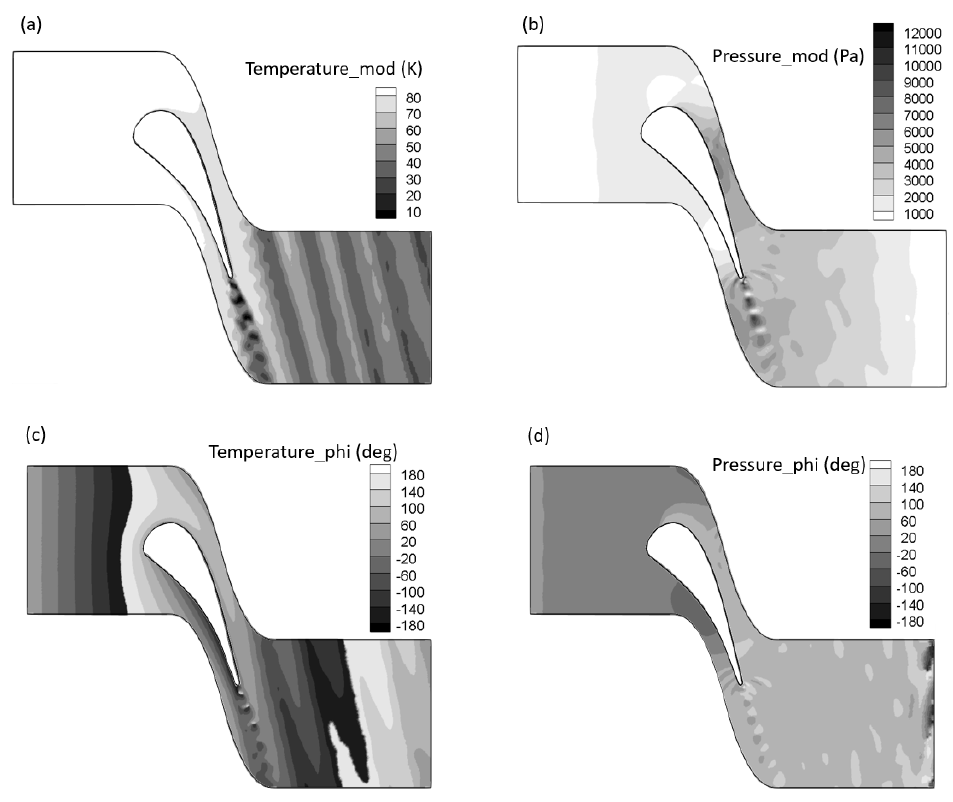
Figure 13. Modulus and phase of the temperature ( a , b ) and pressure ( c , d )—DMD 1 kHz mode. Table 2. Reflection and transmission coe ffi cients for entropy wave frequency Case Calculation